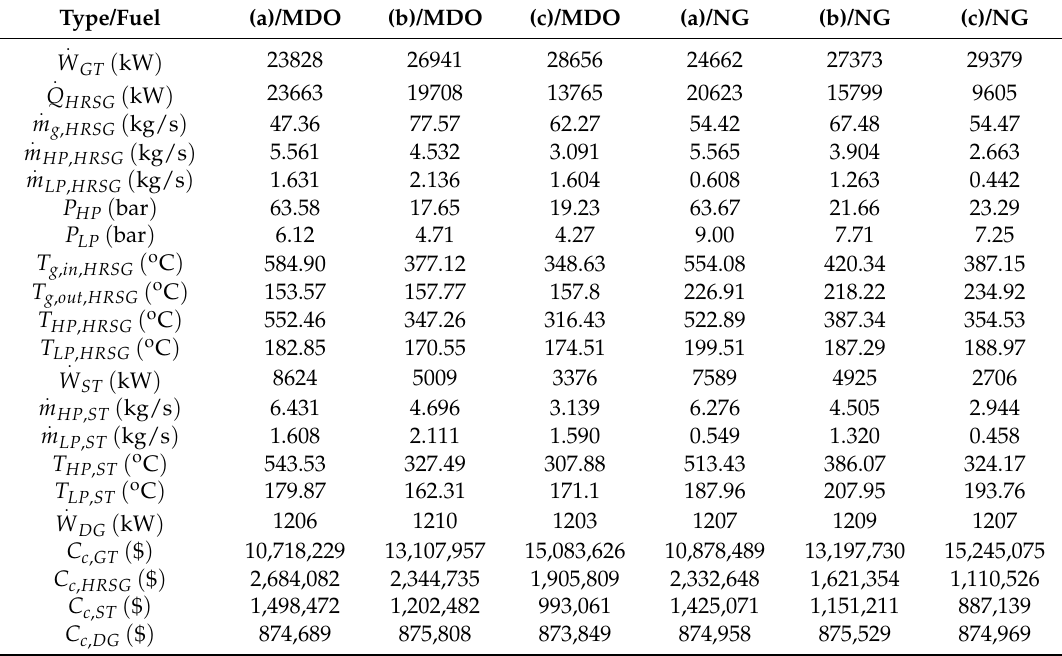
Table 6. Optimal design characteristics and capital cost of components for the six combinations of gas turbine type and